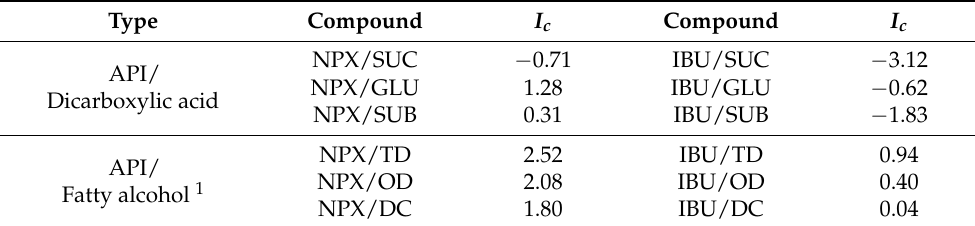
Table 2. The I c values for the API/dicarboxylic acid and API/fatty alcohol